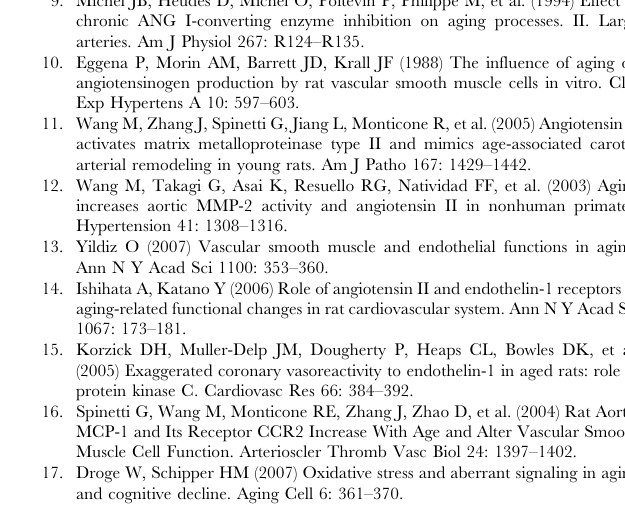
Figure S1 Over-expression of calpain-1 or calpastatin by adenovirus infection. A. Fluorescence photomicrographs show that Adenovirus (GFP or CAST) infected into VSMC. GFP expression was visualized after 48 hrs. Western blots of calpastatin from VSMC infected with CAST virus (right panel). B. Adenovirus (GFP or CANP1) infected into VSMC. GFP 48 hrs. Western blots of calpain-1 from VSMC infected with CANP1 virus (right